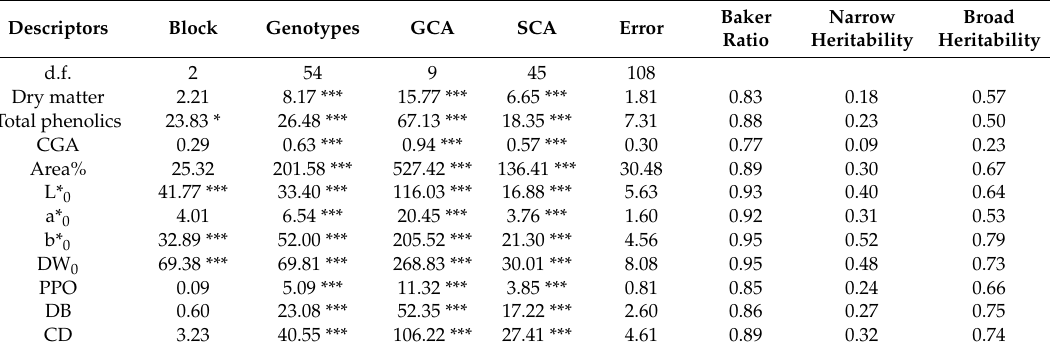
Table 2. Mean squares for block, genotypes, general combining ability (GCA), specific combining ability (SCA), Baker ratio, and narrow- and broad-sense heritabilities for the ANOVA for the fruit traits